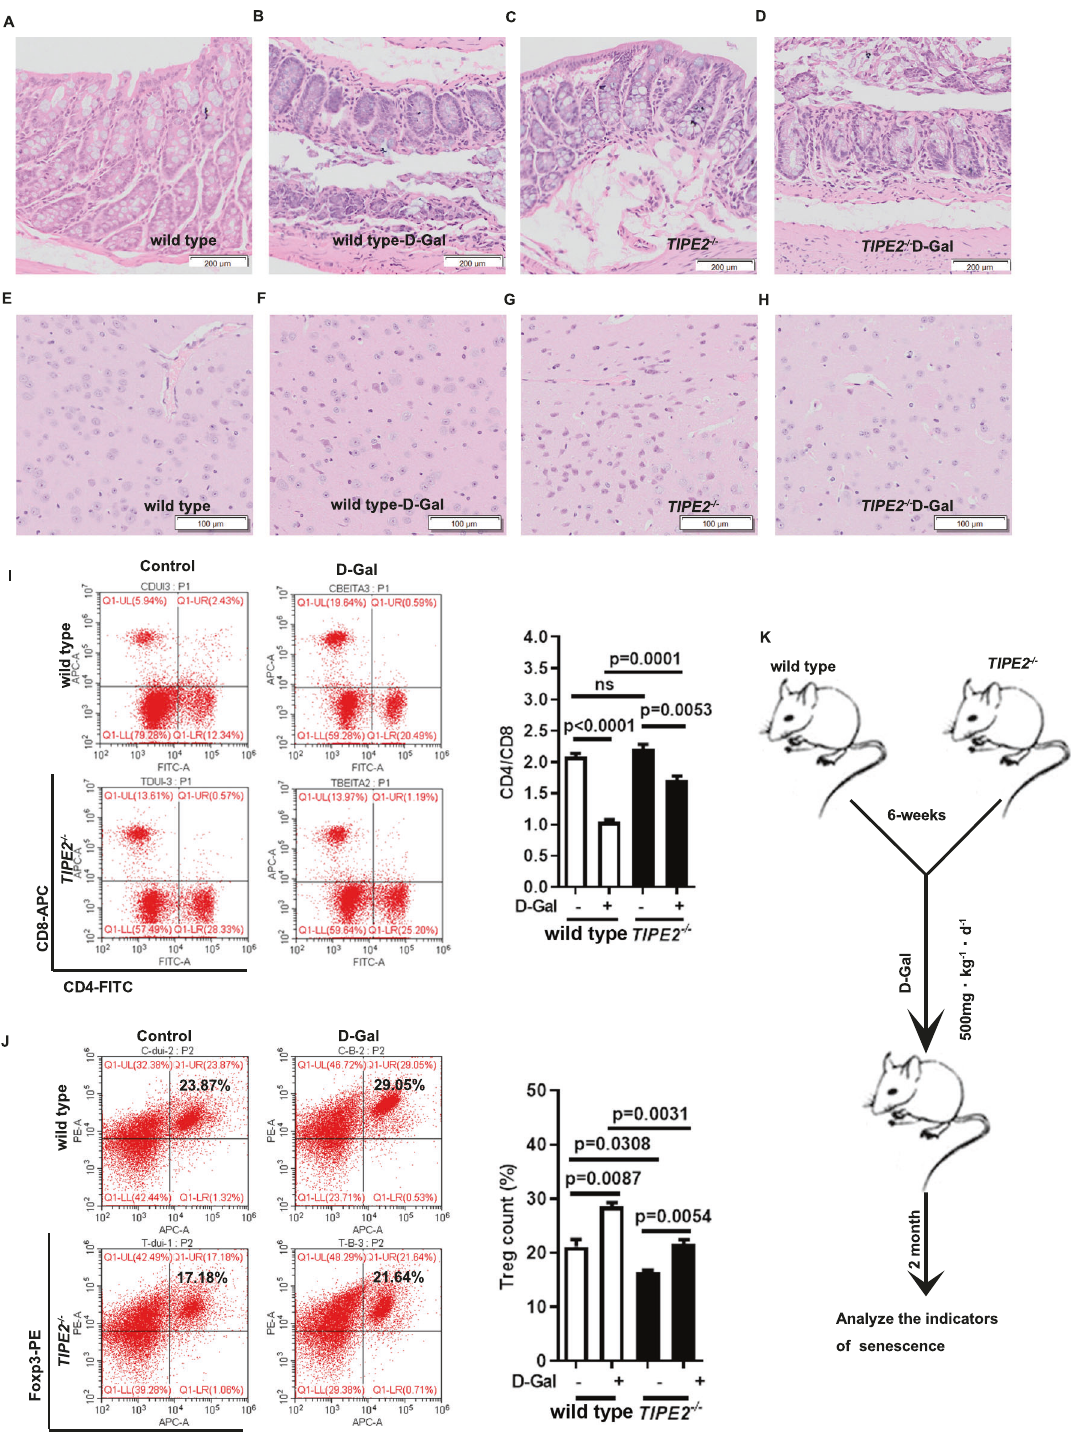
Fig. 3 Tipe2 KO mice were less susceptible to D-Gal-induced aging. The HE staining of intestinal tissues ( A – D ) and brain ( E – H ) from D-Gal induced mice models. Without D-Gal the intestinal or brain from WT ( A , E ) and Tipe2 -/- ( C , G ) showed no difference. Severe age-related morphology was observed in intestinal and brain from WT mice ( B , F ) treated with D-Gal compared to Tipe2 -de fi cient mice ( D , H ). Tipe2 KO mice treated with D-Gal showed a less serious inverse of CD4:8 ratio ( I ) and a lower percentage of Tregs ( J ) compared to WT controls. K The procedure of D-Gal induced aging mouse model. Data are representative of three independent experiments and expressed as means ± SEM. Signi fi cant difference between two groups was determined using an unpaired two-tailed Student ’ s t -test. * P < 0.05, ** P < 0.01, *** P < 0.001. Data from I and J were collected using BECKMAN COULTER CytoFLEXS, then analyzed using